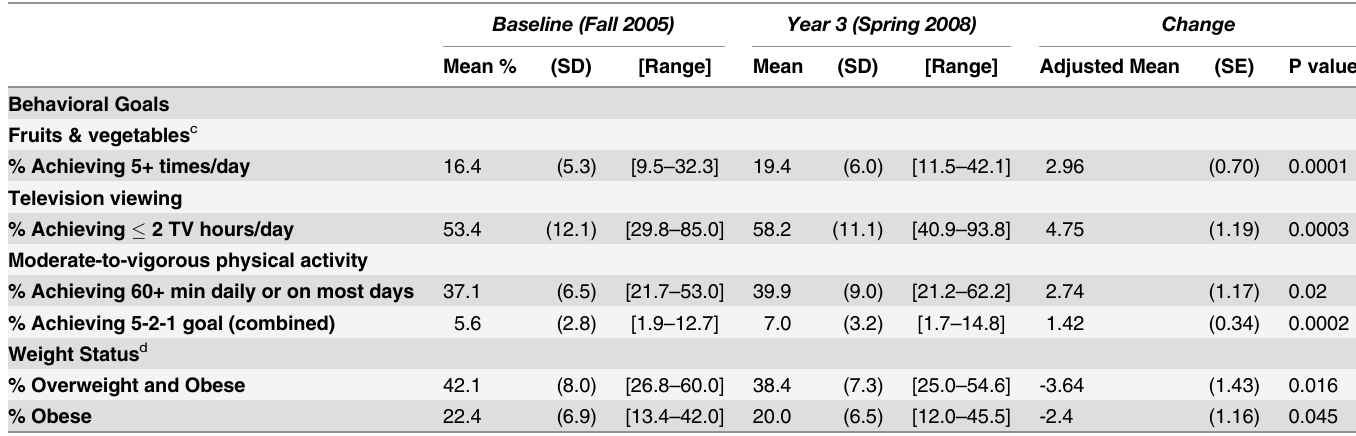
Table 2. Percent across Schools Achieving Behavioral Goals a and Percent Overweight and Obese at Baseline and 3-Year Follow-up b